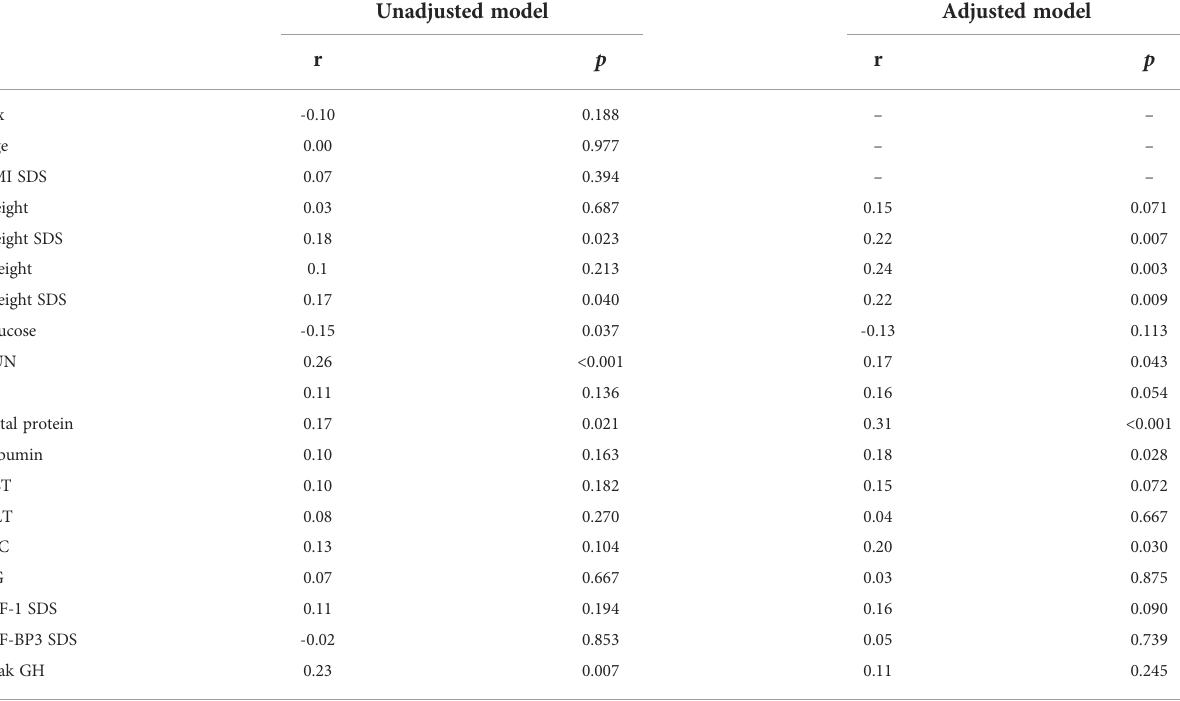
BMI, body mass index; SDS, standard deviation score; AST, aspartate aminotransferase; ALT, alanine aminotransferase; T-C, total cholesterol; TG, triglyceride; IGF-1, insulin-like growth factor-1; IGF-BP3, insulin-like growth factor-binding protein 3; GH, growth hormone. The adjusted model was used after controlling for sex, age, and BMI SDS Table 3. In the unadjusted multiple linear regression analysis, the height SDS was signi fi cantly and positively associated with UA levels ( b =0.156, p =0.023). Height SDS also had a signi fi cantly positive association with UA levels in the adjusted multiple linear regression analysis after controlling for sex, age, and BMI SDS ( b =0.168, p =0.007). The other variable associated with height SDS in the unadjusted and adjusted multiple linear regression analyses was the weight SDS.